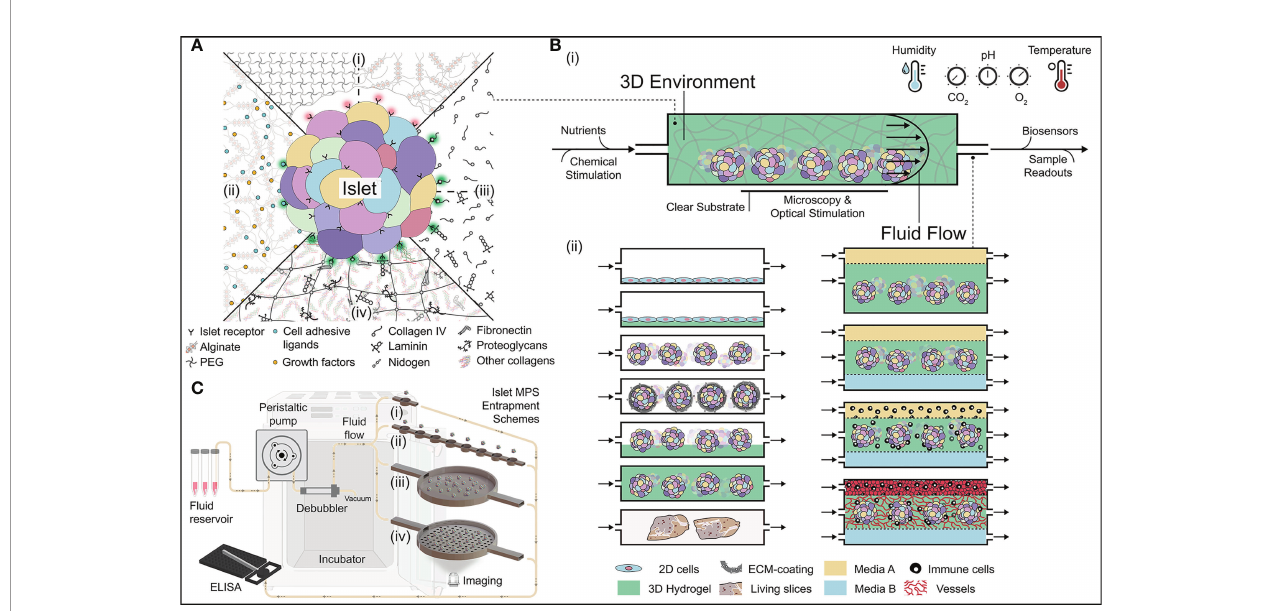
FIGURE 3 | Approaches in building the next generation of 3D islet niche. (A) Schematic of different types of 3D hydrogels for culturing islets. [ A -(i)] Bioinert hydrogels that are naturally non-adhesive to islets. [ A -(ii)] Functionalized bioinert hydrogels with the incorporation of cell adhesion ligands and growth factors. [ A -(iii)] Hydrogels with soluble ECM. They could be made either using singular or complementary sets of ECM molecules. [ A -(iv)] Multi-component decellularized 3D hydrogels with extensive adhesion capabilities to the islets. (B) Fundamental features of islet microphysiological systems (MPS). [ B -(i)] Housing islets within a 3D space require the orchestration of several parameters. [ B -(ii)] Various MPS schemes for housing islets with hydrogels and other cells/tissue types. [ C (i-iv)] Different types of islet entrapment schemes using architectural design. Various accessories needed for culturing islets within the MPS are also visualized. Illustration not drawn to